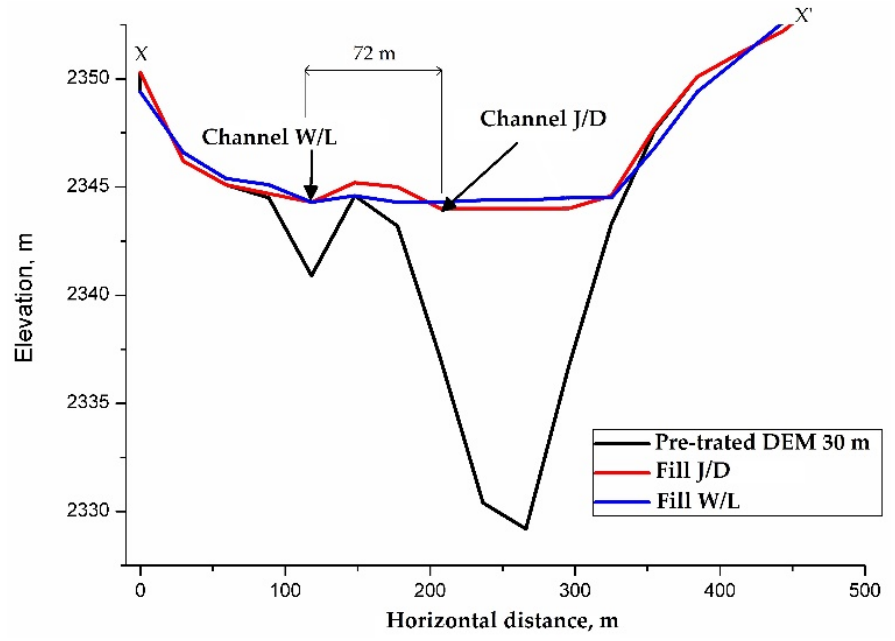
Figure 12. X-X’ axis topographic profiles from DEM 30 m.